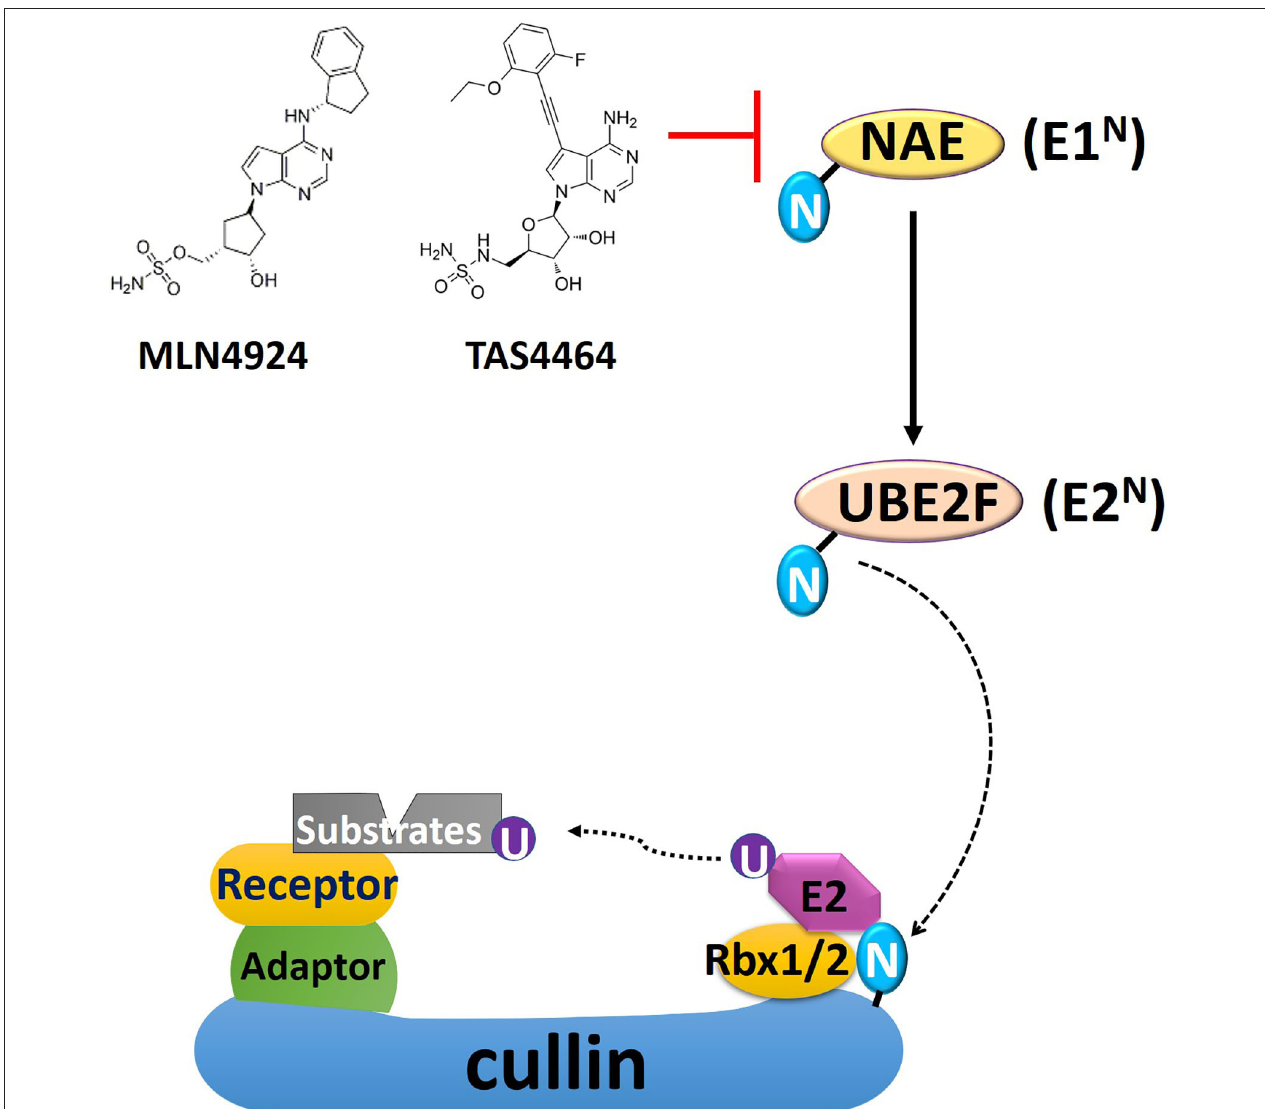
FIGURE 1 | A schematic overview of cullin-RING E3 ligase (CRL) and NEDD8 conjugation. Conjugation of NEDD8 to the scaffold cullin protein in the CRL is carried out in three enzymatic steps involving NEDD8-activating enzyme (NAE, E1 N ), UBC12, and UBE2F (E2 N ). The substrate receptor protein, docked in the CRL complex by binding to the adaptor protein, recruits substrates for ubiquitin conjugation. MLN4924 and TAS4464 are specific NAE inhibitors, prohibiting NEDD8 conjugation and thus inhibit CRL activity. The 2-D structure of MLN4924 and TAS4464 was derived from Yu et al. (34). N, NEDD8; U, ubiquitin; Rbx, RING box